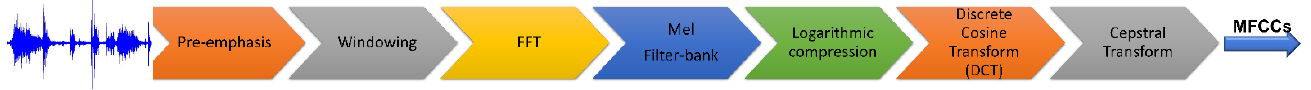
Figure 2. Block diagram of MFCCs feature extraction modules.